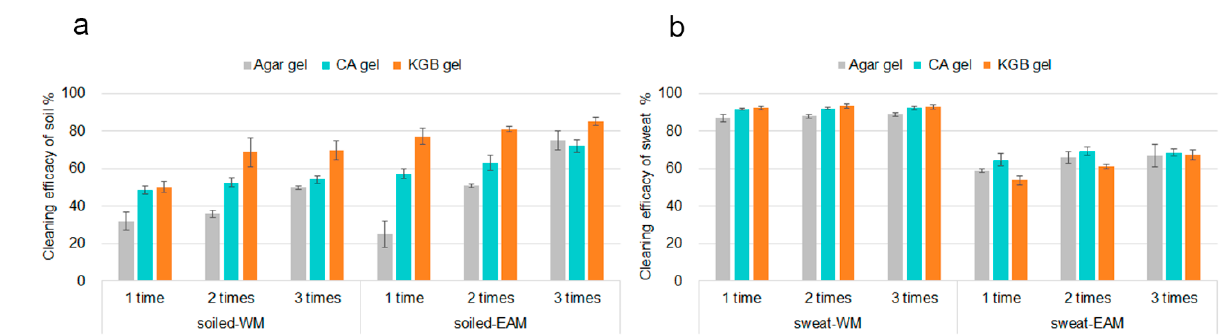
Figure 3. Cleaning efficacy values obtained on soiled-WM and soiled-EAM ( a ) and on sweat-WM and sweat-EAM ( b ). The percentage of cleaning efficacy was calculated based on the counts of Ca for soiled mock-ups and Cl for sweated ones. Agar, CA, and KGB gels were applied 1 to 3 times on both soiled- and sweat-contaminated mock-ups.